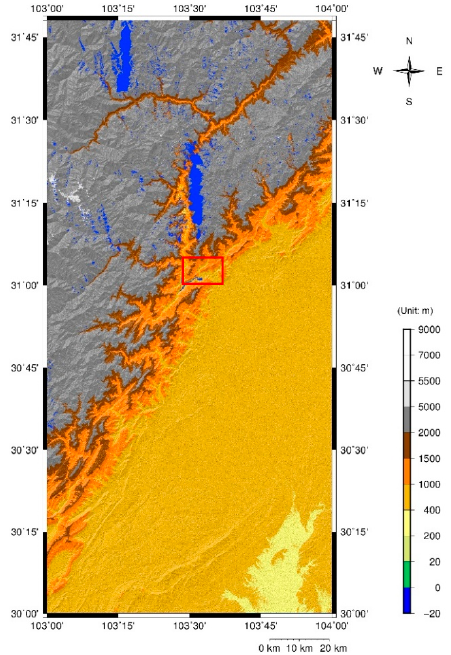
Figure 4. The TanDEM-X 12 m DEM colorized and hill-shaded map of the two 12 m TanDEM-X DEM tiles whose location is shown in Figure 3; the red rectangle box area is the study site; the blue areas are holes caused by low coherence or shadow.